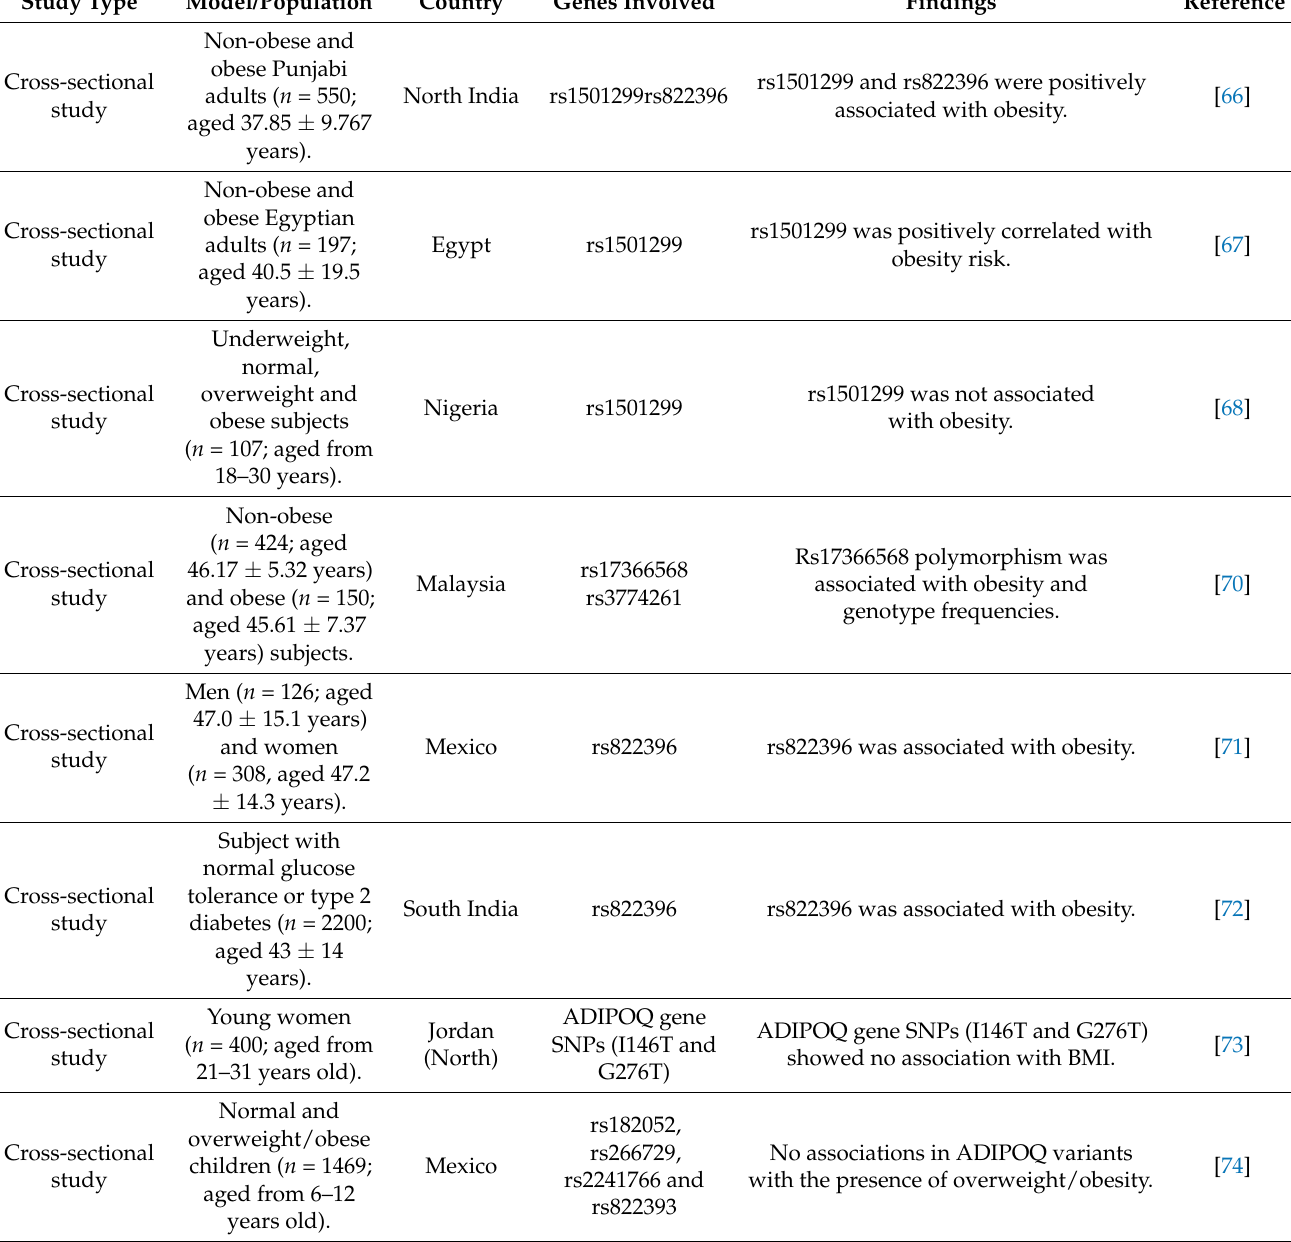
Table 3. The relationship between adiponectin and